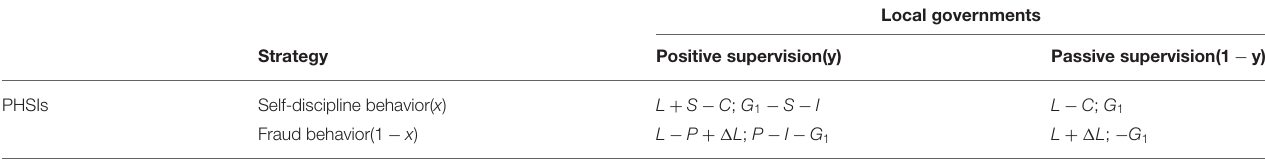
TABLE 1 | The payoff matrix of both players.